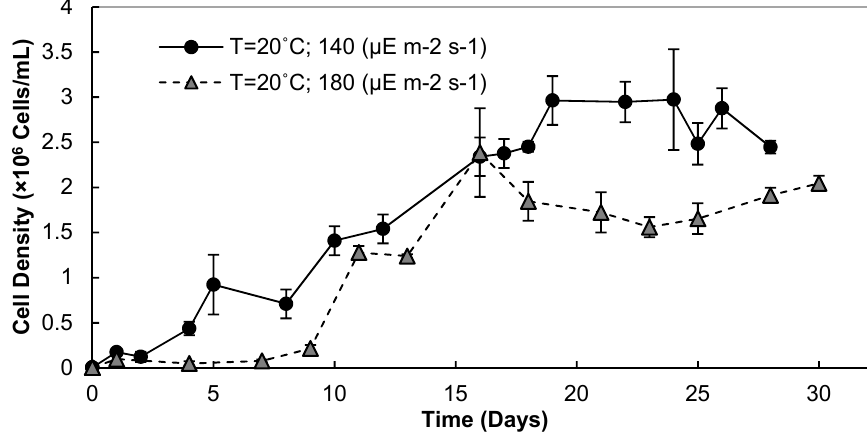
Figure 2. Cell density (×10 6 cell/mL) of P. cruentum at different light intensities of 140 µE m − 2 s − 1 and 180 µE m − 2 s − 1